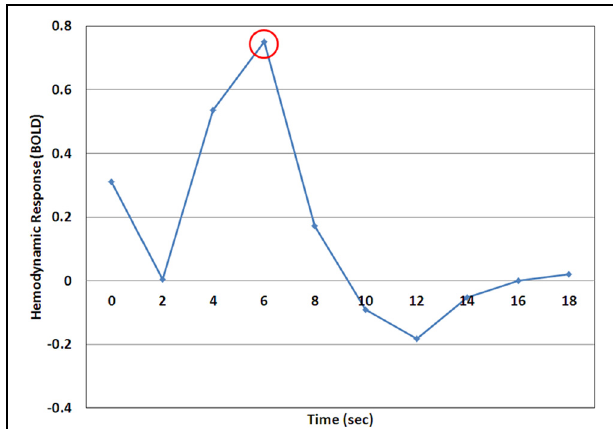
FIGURE 3 | A representative example of the hemodynamic response (HDR) as calculated by the deconvolution analysis. In this case the time point at 6s (encircled) would be considered the HDR-peak and the value at this time point would be used for analysis.